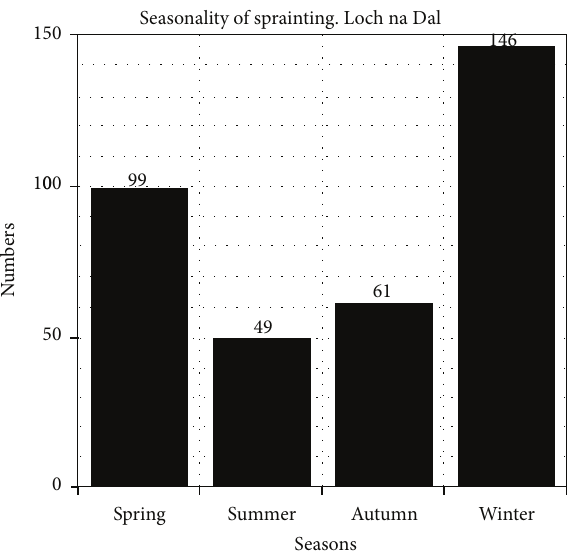
Figure 2: Seasonality of sprainting on the Ardnish peninsula.